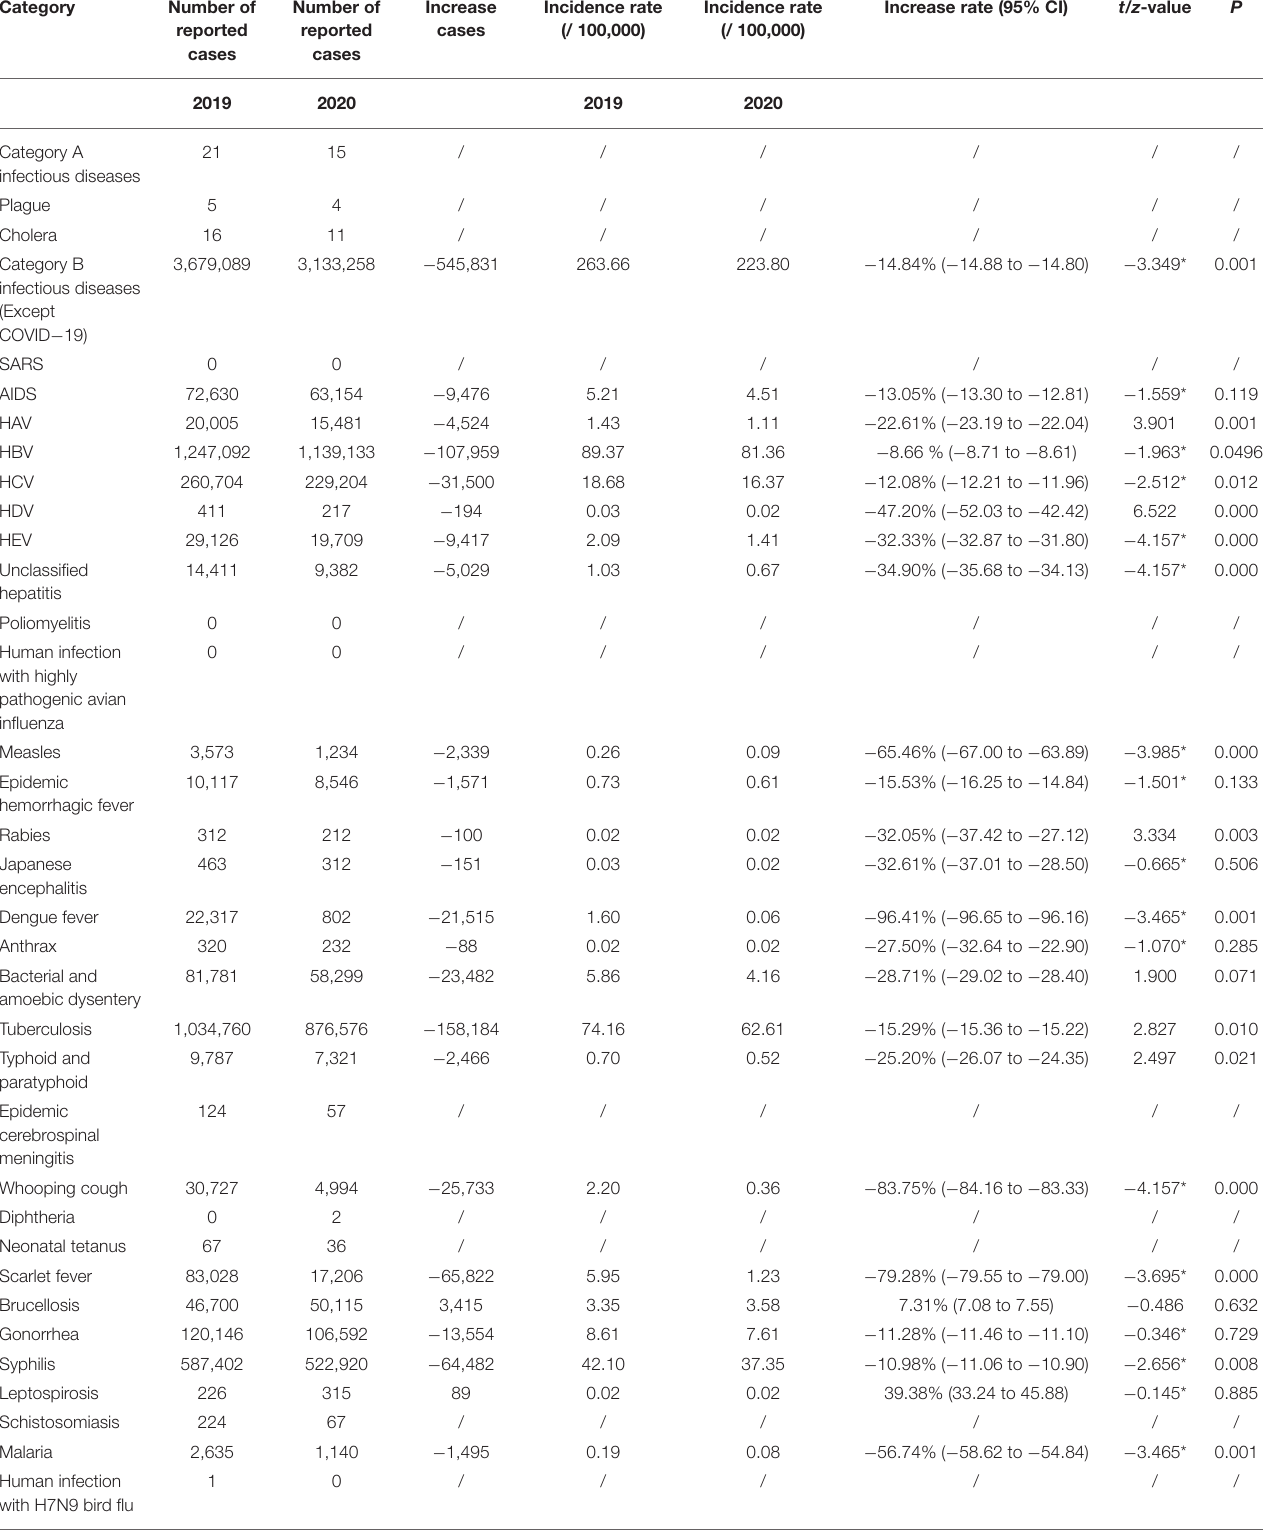
TABLE 1 | Incidence of notifiable infectious diseases nationwide in 2019 and 2020.